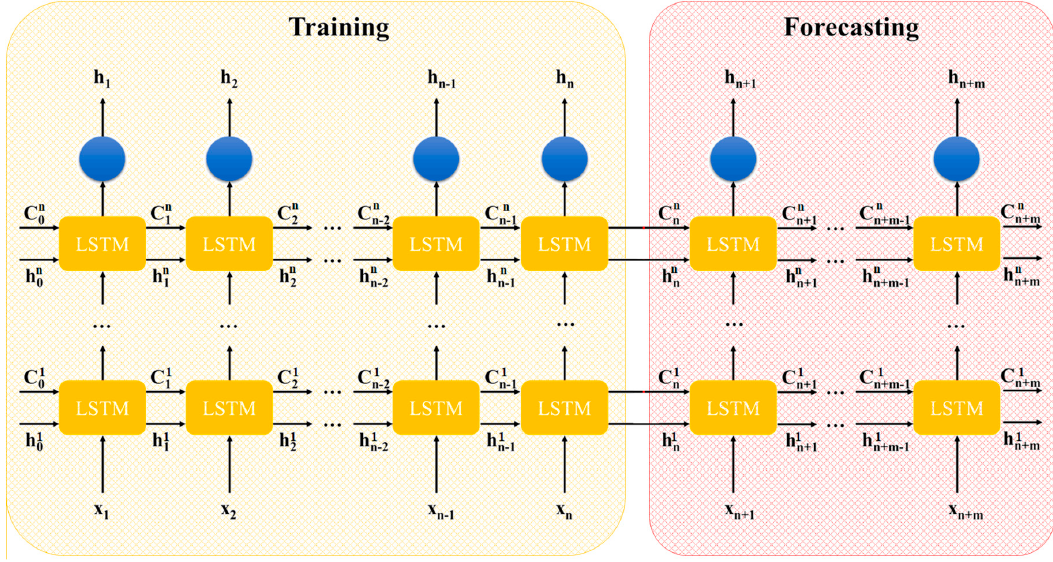
Figure 3. The LSTM network.